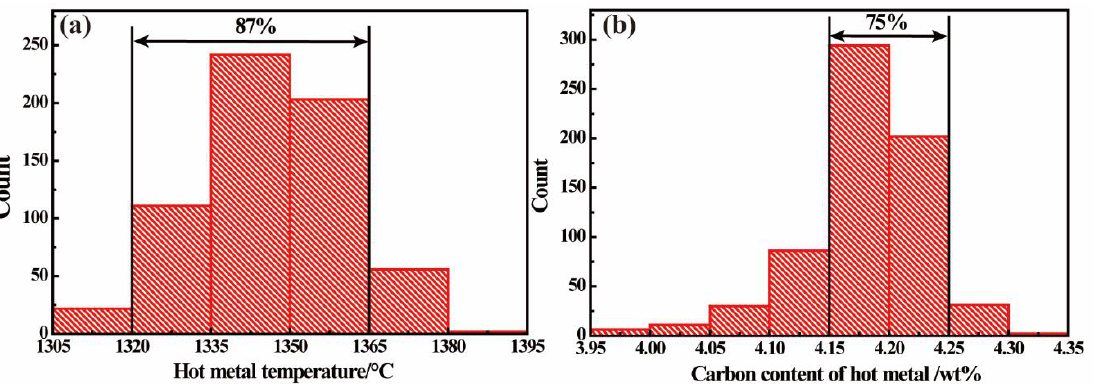
Figure 2. Hot metal conditions of the 120 t converter. ( a ) Distribution of hot metal temperature. ( b ) Distribution of carbon content of hot meta.